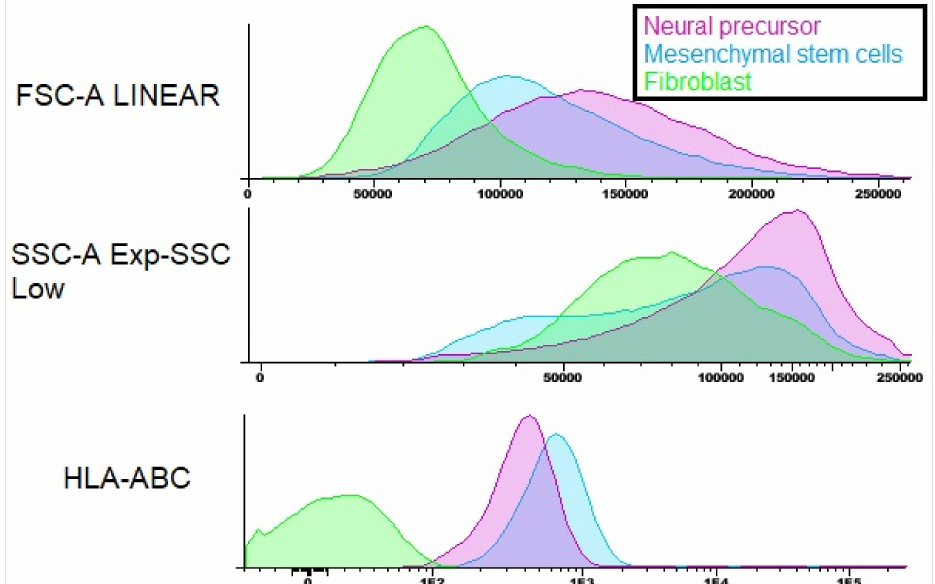
Figure 11. Flow cytometry of the HLA-ABC histocompatibility complex molecule. Note: Neural precursor—purple; MSC—blue; fibroblast—green.